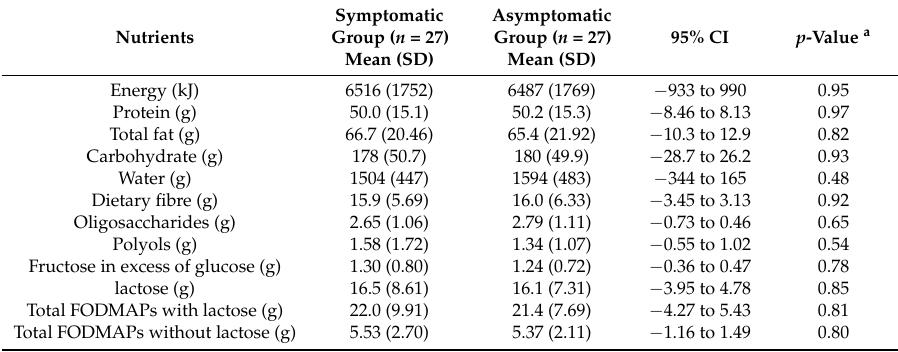
Table 4. Average daily intake of macronutrients and FODMAPs consumed by symptomatic and asymptomatic